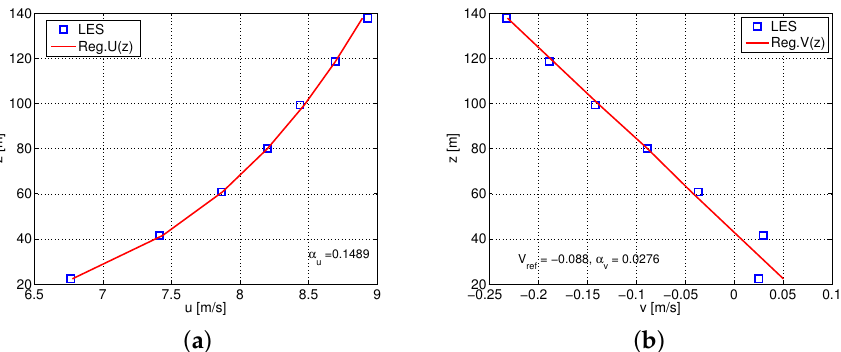
Figure 14. Free-stream mean profiles: regression vs. Large-Eddy Simulation (LES) data: ( a ) free-stream u component mean profile; and ( b ) free-stream v component mean profile. Table 1. Free-stream mean profile regression